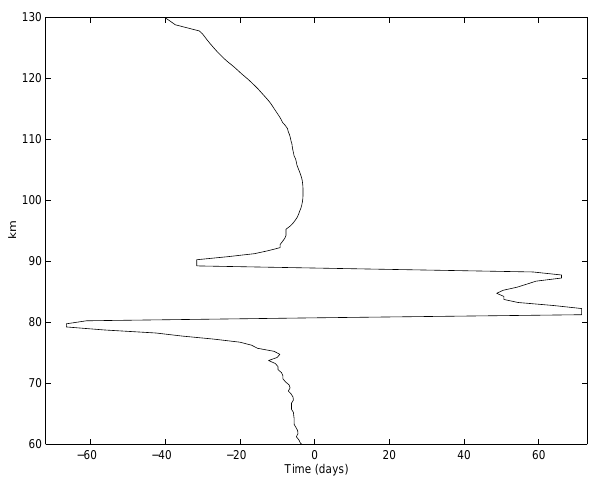
Fig. 10. Radiative relaxation time corresponding to cooling/heating rates of CO 2 between 50–150km altitude for 14–16 July